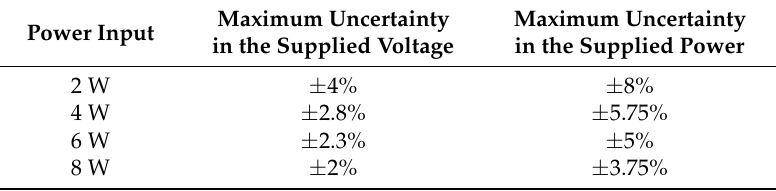
Table 4. Uncertainties in supplied voltage and supplied power.